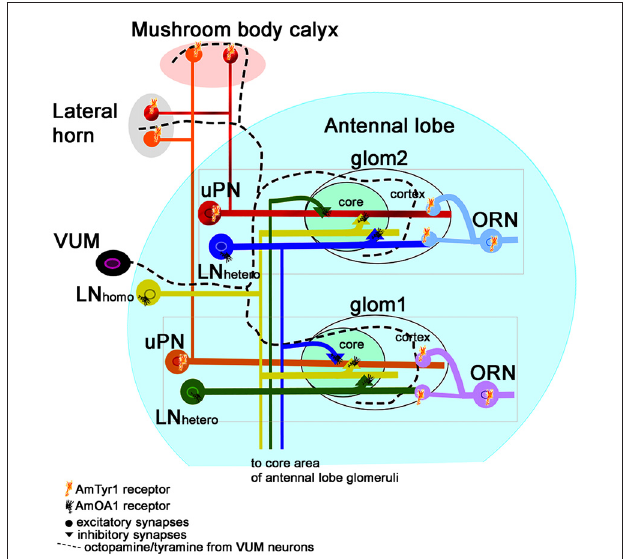
FIGURE 8 | Schematic view of the neural network proposed for the honey bee antennal lobe (modified from Sinakevitch et al., 2013). Each glomerulus can be defined by three types of neurons that are tuned to a narrow range of odorants: (i) ORN axons that project excitatory branches into the cortex of the glomerulus; (ii) the glomerular uPNs that receive input in both the cortex and core of the glomerulus and project excitatory output branches to the LH and Mushroom body calyx; and (iii) inhibitory hetero-LNs that branch in all areas of the glomerulus (cortex and core), where they receive excitatory output from the cortex and inhibitory from the core. Hetero-LNs also have inhibitory input in the core area of one glomerulus. Hetero-LNs also have two types of neurotransmitter (GABA and Histamine, Dacks et al., 2010). The neurons that interconnect all glomeruli are multiglomerular LNs (containing both GABA and Allatostatin, Kreissl et al., 2010). They have input/output branches in the core area where they inhibit neurons in the core. There are also multiglomerular inhibitory GABAergic mPNs that are not illustrated here. We propose that VUM neurons release both octopamine and tyramine in the antennal lobe, LH and mushroom body calyx. Each glomerulus will respond to the presence of each biogenic amine through specific receptors. Inhibitory LNs (hetero and homo) express AmOA1. The ORN axons express AmTyr1, and the uPNs axons in the LH and Mushroom body calyx also express AmTyr1 receptors. In both cases, AmTyr1 is in a position to regulate excitatory transmission into the respective areas. We hypothesize that the action of octopamine and tyramine released by VUM could be dependent on the ratio of the amines and on the specific target cells that express the receptors. An excess of octopamine in a glomerulus leads to inhibiting the inhibition in the core and simultaneously blocks excitation in neighboring glomeruli via AmOA1 on GABAergic LNs. An excess of tyramine inhibits the release of the excitatory neurotransmitter in the